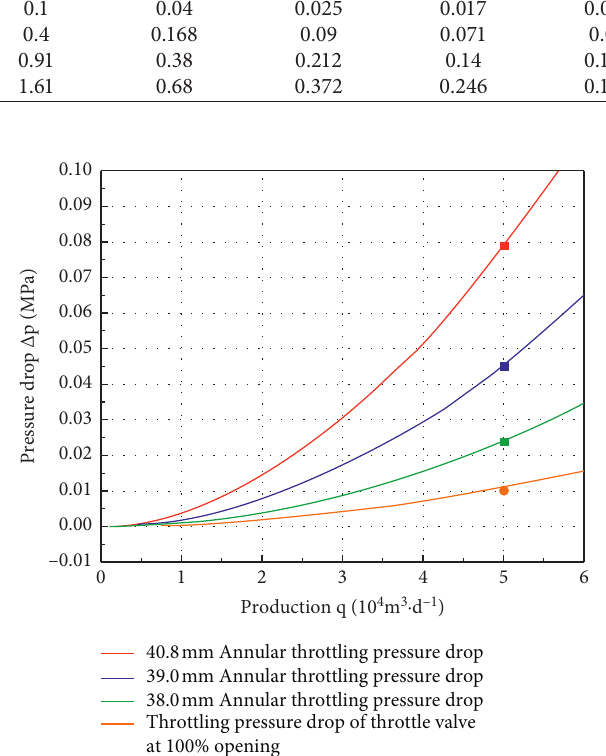
Figure 5: Comparison of annular pressure drop and pressure drop of fully open throttle